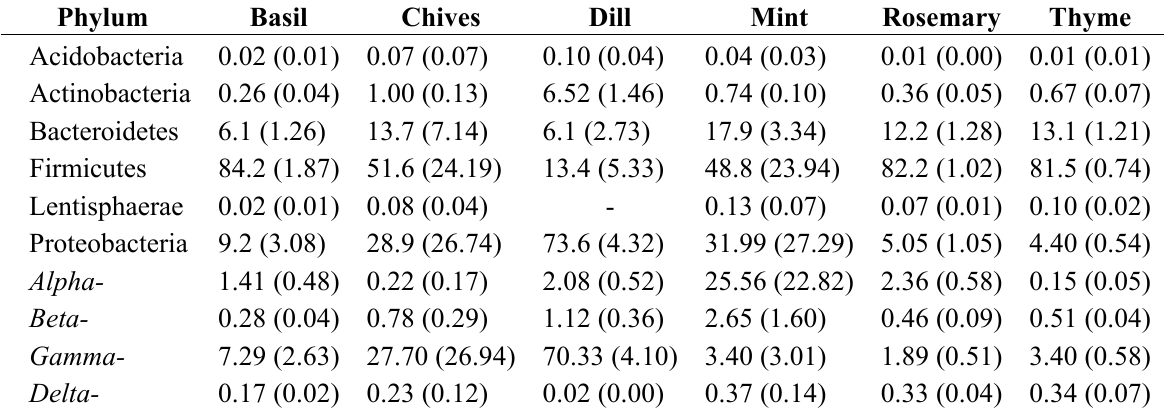
Table 1. Major phyla and subphyla of bacteria associated with prepackaged fresh herbs sampled from a grocery store in Mississippi, USA, as determined from high throughput 16S rRNA gene sequencing. Numbers represent mean (+/ − SE) percentage of total sequence reads obtained from 3 samples per herb that were identified as that